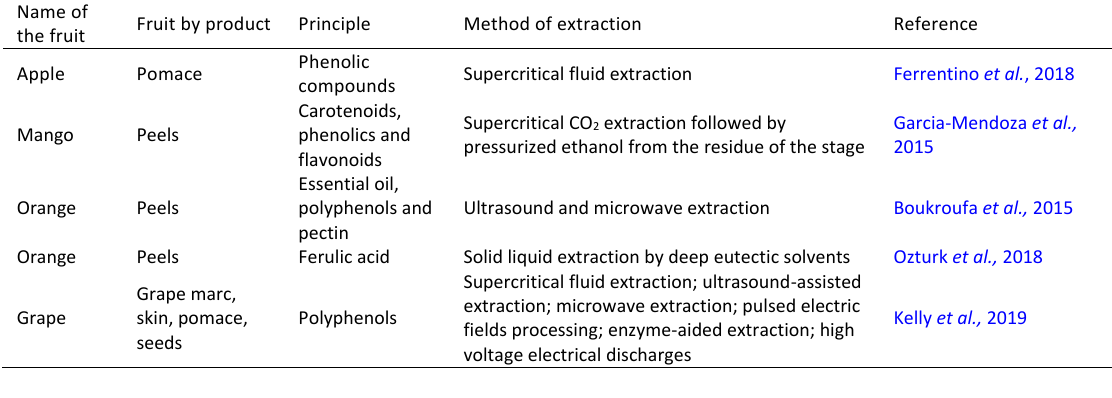
Table 1: List of by-products extracted from different fruits